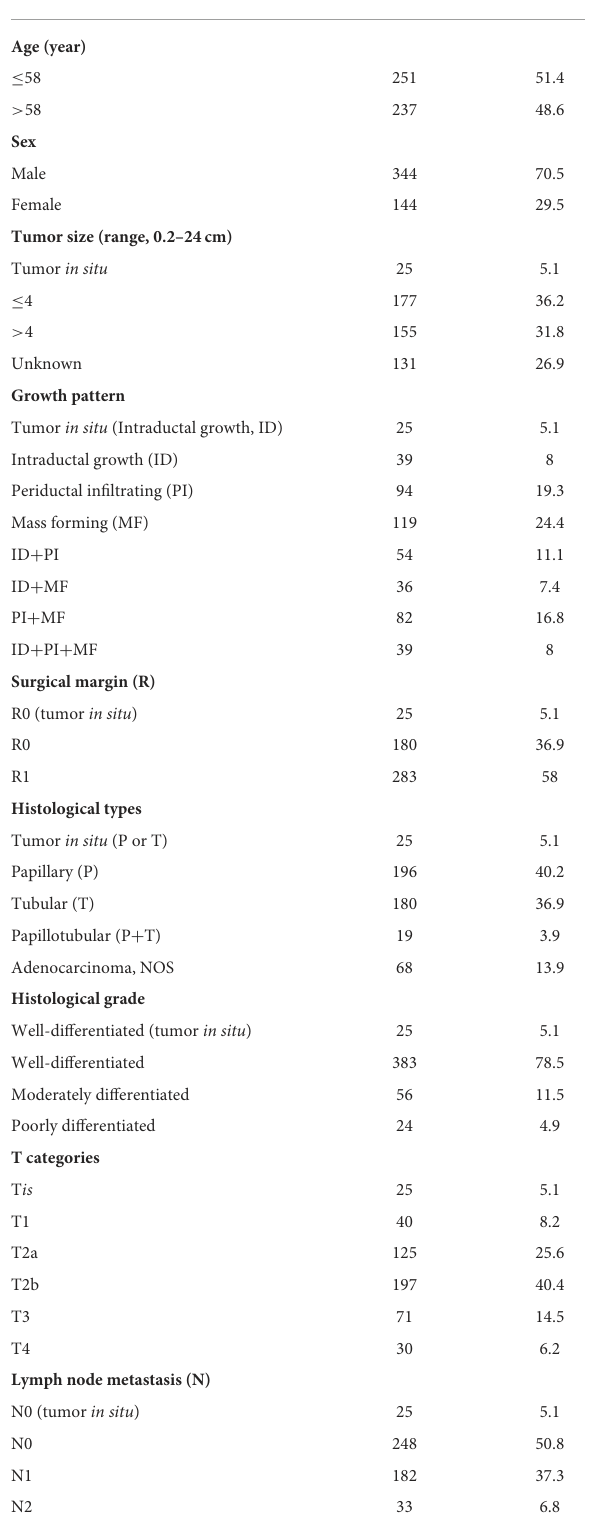
TABLE 2 Clinicopathological features of patients with perihilar